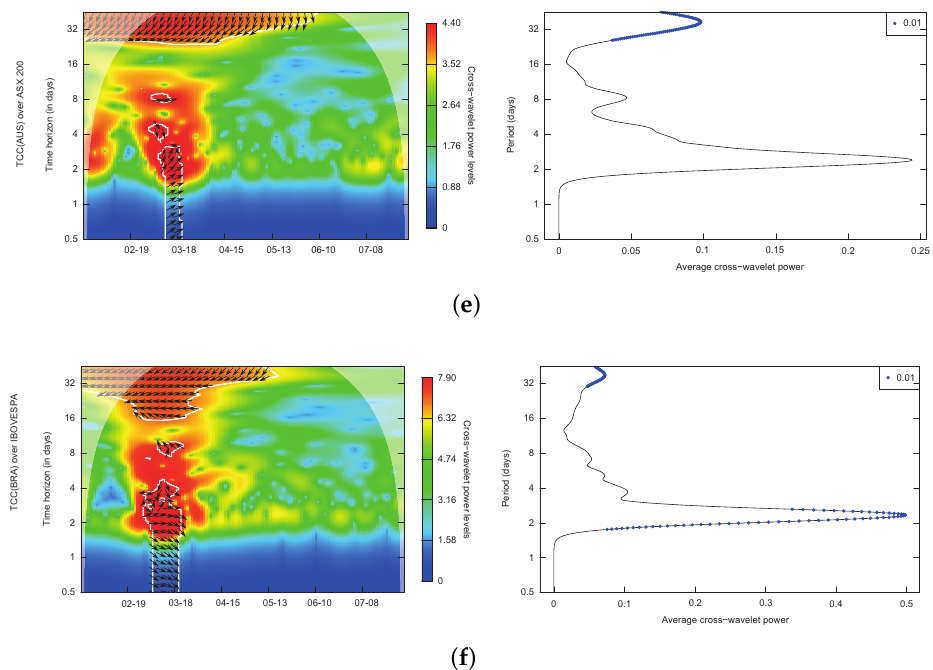
( f ) Figure 6. Contour plots of the wavelet coherence among the six stock indices analyzed and the cases of COVID-19 registered in the respective countries. Corresponding average cross-wavelet powers. ( a ) Wavelet coherence: NYSE returns vs. increase in COVID-19 cases in the U.S. Average cross-wavelet power, ( b ) Wavelet coherence: DAX returns vs. increase in COVID-19 cases in Germany. Average cross-wavelet power, ( c ) Wavelet coherence: NIKKEI 225 returns vs. increase in COVID-19 cases in Japan. Average cross-wavelet power, ( d ) Wavelet coherence: JSE TOP-40 USD returns vs. increase in COVID-19 cases in South Africa. Average cross-wavelet power, ( e ) Wavelet coherence: ASX 200 returns vs. increase in COVID-19 cases in Australia. Average cross-wavelet power and, ( f ) Wavelet coherence: IBOVESPA returns vs. increase in COVID-19 cases in Brazil. Average cross-wavelet